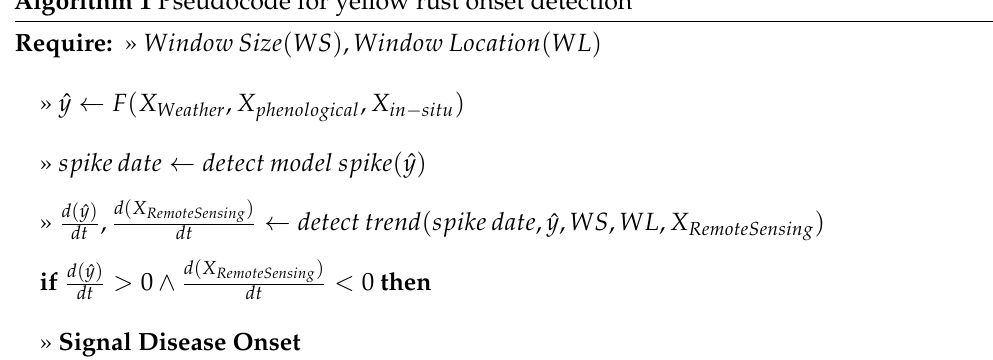
Algorithm 1 Pseudocode for yellow rust onset